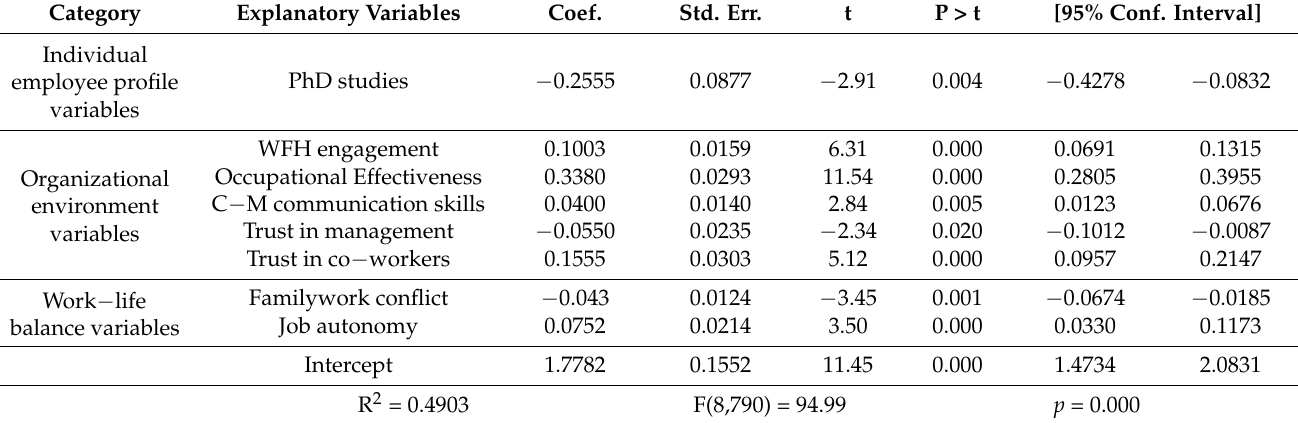
Table 2. Multiple linear regression analysis results related to social performance—backward selection.